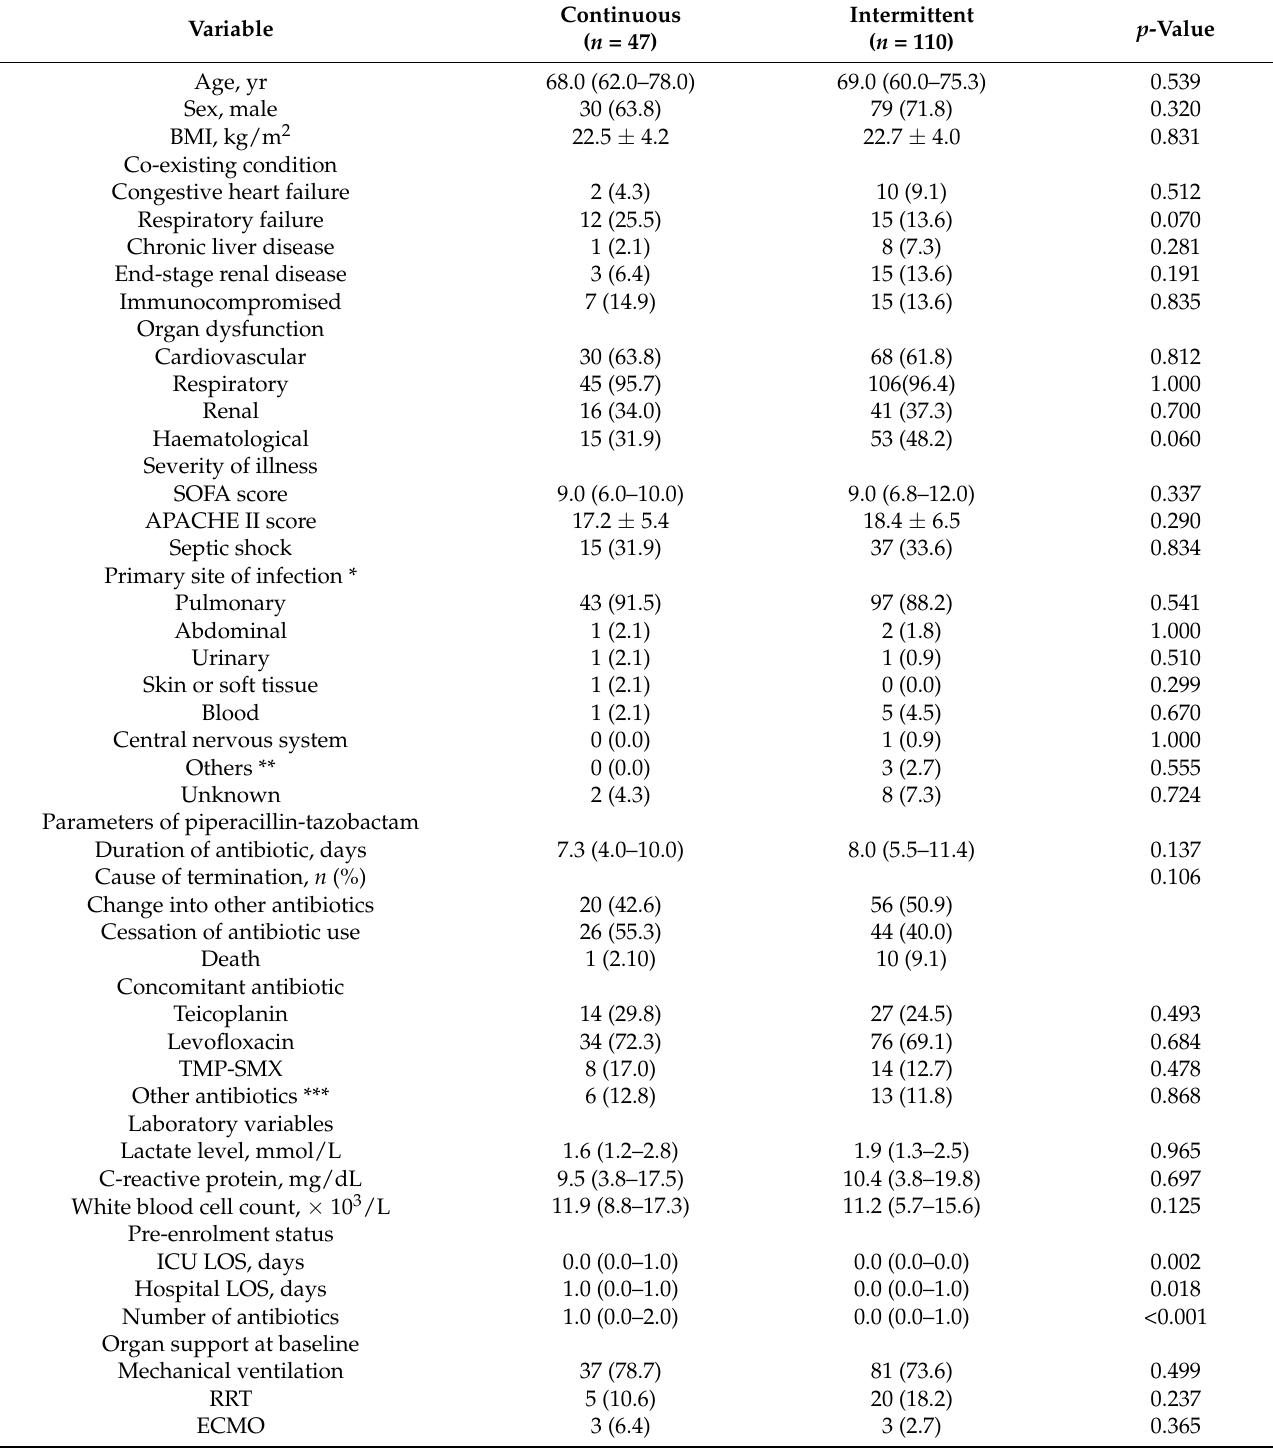
Table 1. Baseline demographics and clinical characteristics of patients by the type of administration of